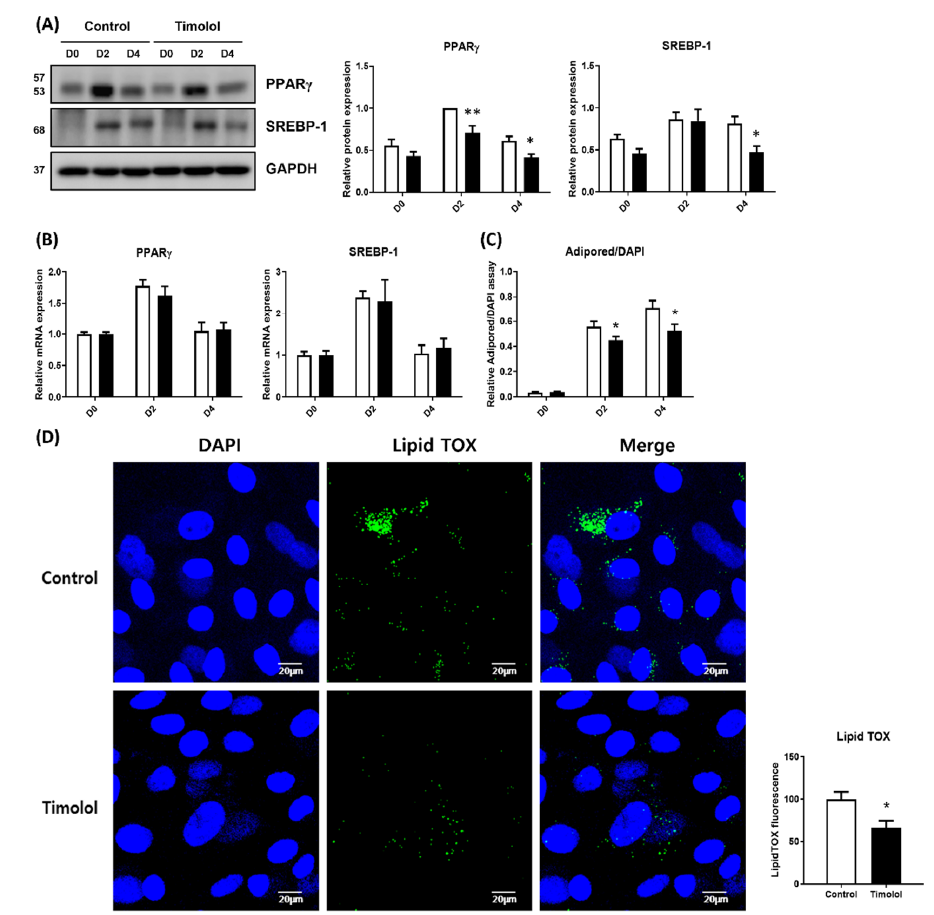
Figure 4. Beta 2-adrenergic antagonist inhibits lipogenesis in HMGECs. HMGECs were cultured with or without timolol (0.0002%; timolol was treated at days 0 and 2). ( A , B ) mRNA and protein expression levels of PPAR γ and SREBP-1 were assessed by quantitative PCR and immunoblotting on days 0, 2, and 4 (the sum of 3 and 4 experiments, respectively). ( C , D ) Lipid synthesis was measured by AdipoRed assay and LipidTOX assay at day 4, and the results of three experiments are summarized. Data are presented as mean ± standard error of the mean. D, days after differentiation; * p < 0.05; ** p <